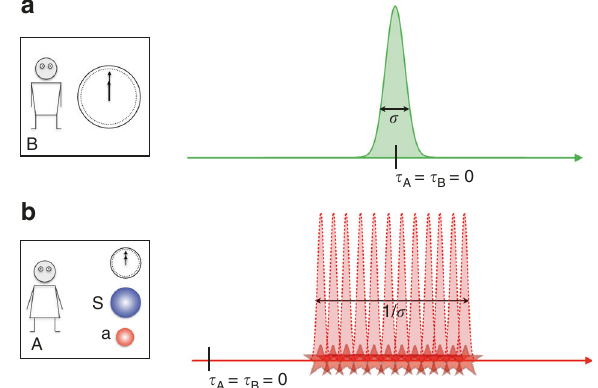
Fig. 3 Gravitating quantum clocks from the point of view of C. In a thought experiment, A ( b ) sets up an event, consisting in an interaction between S (blue ball) and a (red ball), when her clock shows a certain time t (cid:4) . A ’ s clock is in fl uenced by a gravitational fi eld sourced by the energy of A B ’ s clock ( a ). The initial quantum state of B ’ s clock (depicted by the green (cid:8) Gaussian) has a characteristic width σ , which speci fi es its accuracy (the Ψ j i ¼ 0 ; ð 12 Þ smaller σ , the higher the accuracy). As a consequence, the energy of B ’ s clock is not well de fi ned — it has an uncertainty of 1/ σ . Therefore, the gravitational fi eld sourced by B is not well de fi ned either. As a consequence, the time dilation of clock A becomes uncertain from the point of view of C. This is shown by the “ fuzzy ” red wave packets representing A ’ s clock state. By Eq. (13), this uncertainty leads to an inde fi niteness in the localisation of A ’ s event, as depicted by the “ fuzzy ” red stars on the bottom of the wave